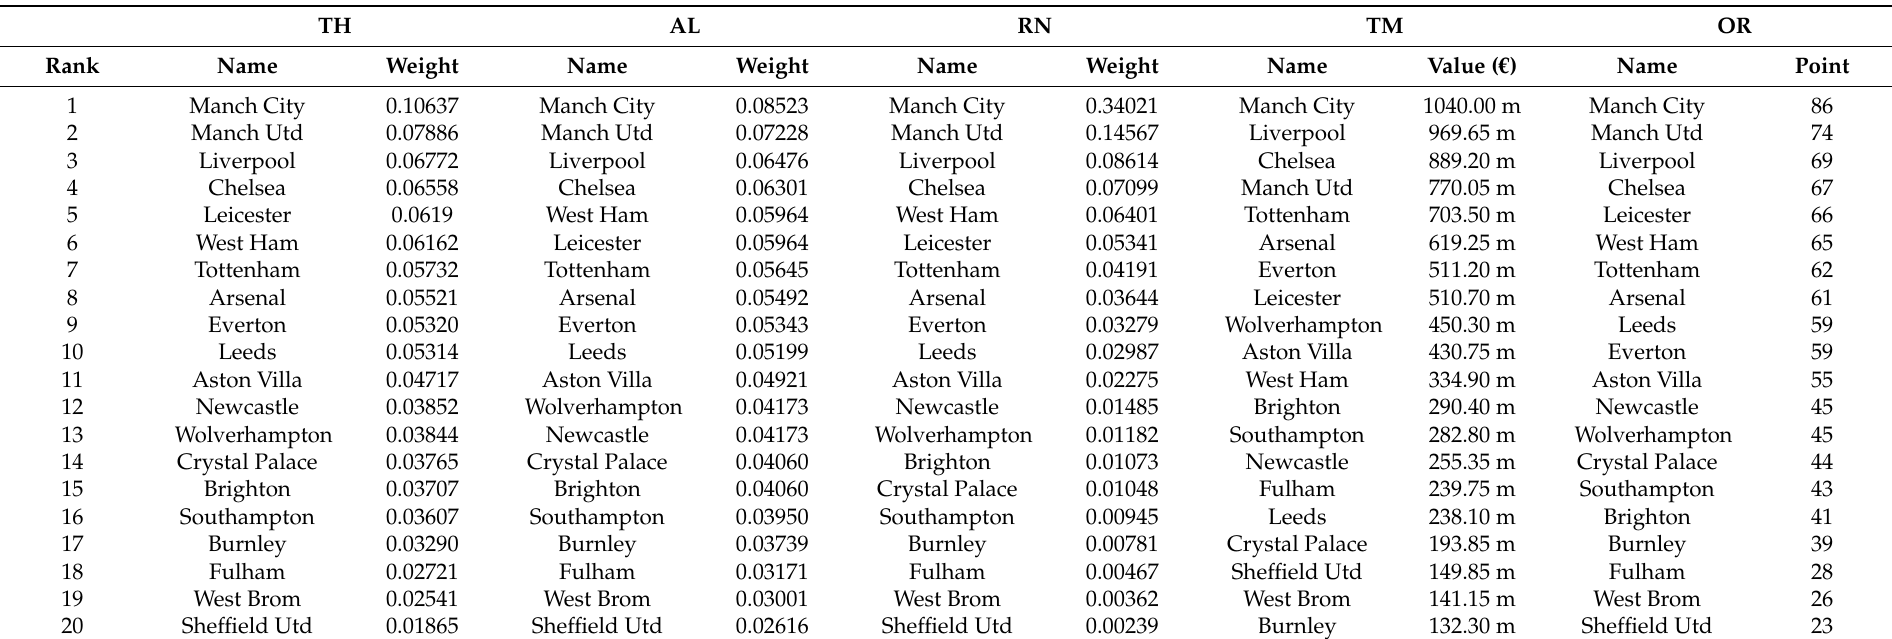
Table 2. Evaluations of the Premier League teams based on their matches in the national championship by different methods (Thurstone (TH), analytic hierarchy process with LLSM method (AL), and RankNet (RN)); the financial values of the teams based on Transfermarkt (TM) data; and the official ranking (OR) based on the number of points received in the Premier